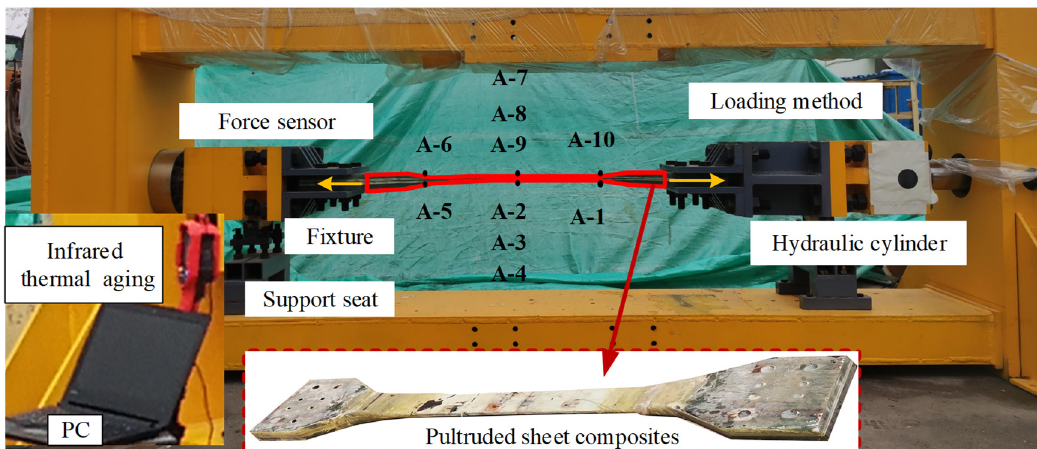
Figure 9. Static tensile test site of pultruded